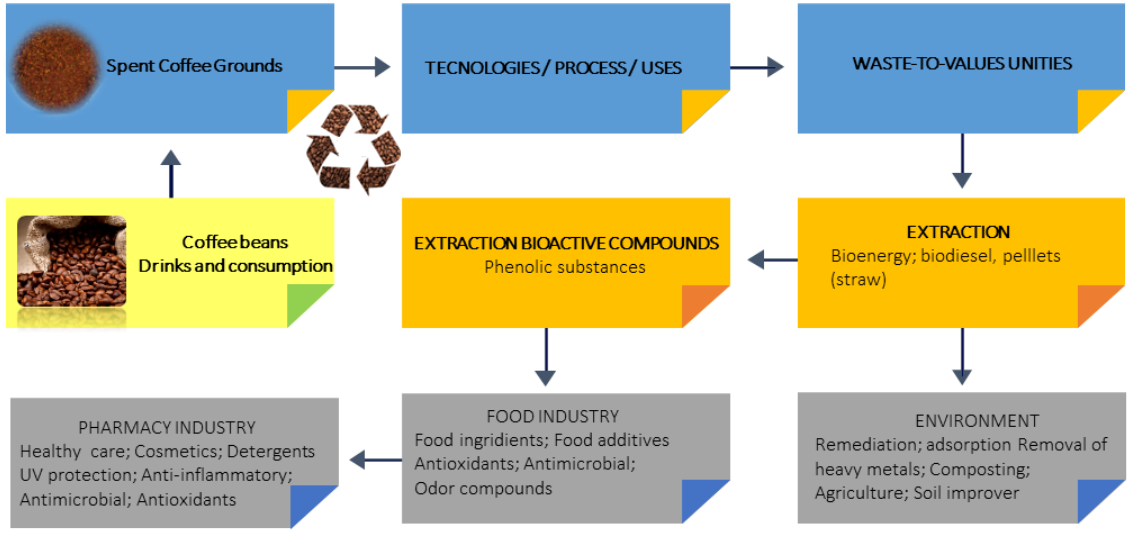
Figure 2. Overview of potential usages of spent coffee grounds.